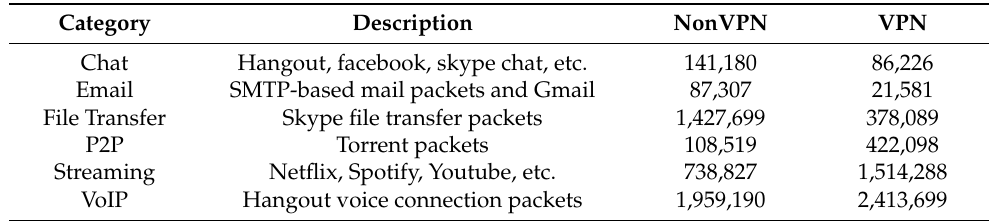
Table 3. ISCXVPN2016 dataset summary.